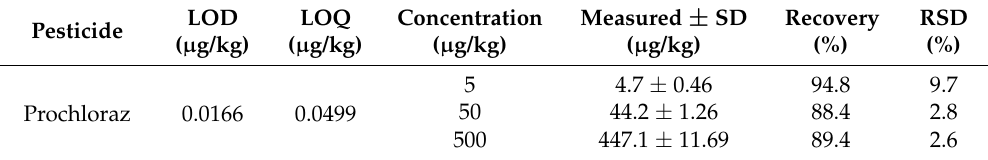
Table 3. UPLC-MS/MS recovery studies of samples spiked with prochloraz ( n =